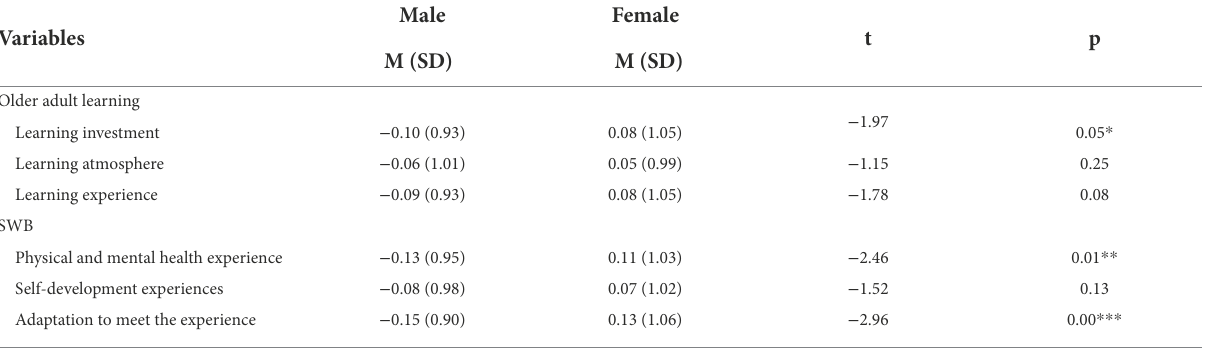
TABLE 5 Results of independent-samples t-test ( n = 436).